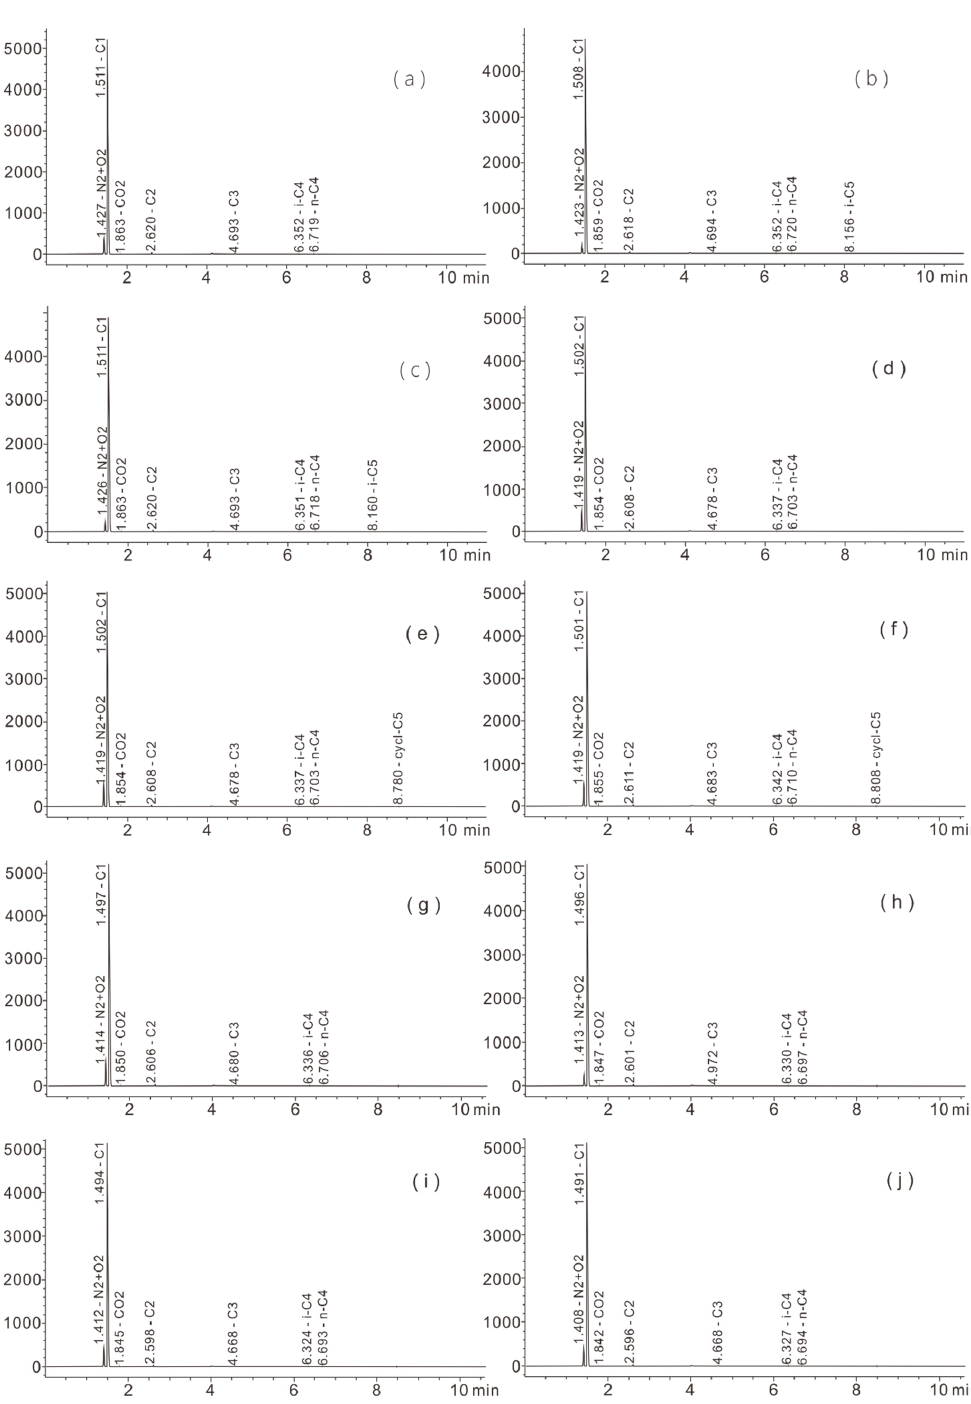
Figure 2. The representative GC curves of the gas samples from China’s first offshore gas hydrate production test in SCS. ( a , b ) stand for the GC curves of gas extracted from the early depressurization; ( c – h ) are the curves of the gas samples from the middle production; ( i , j ) are the samples from the late production. All of the samples exhibit a large C1 peak and other weak peaks, which show that all of the gas samples are predominated by CH 4